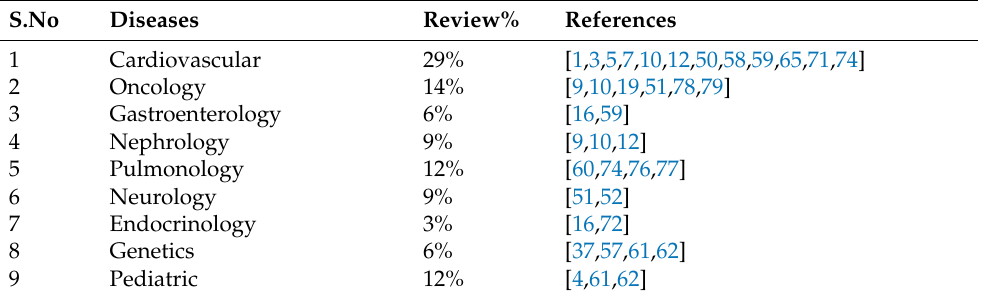
Table 4. Critical review on various diseases